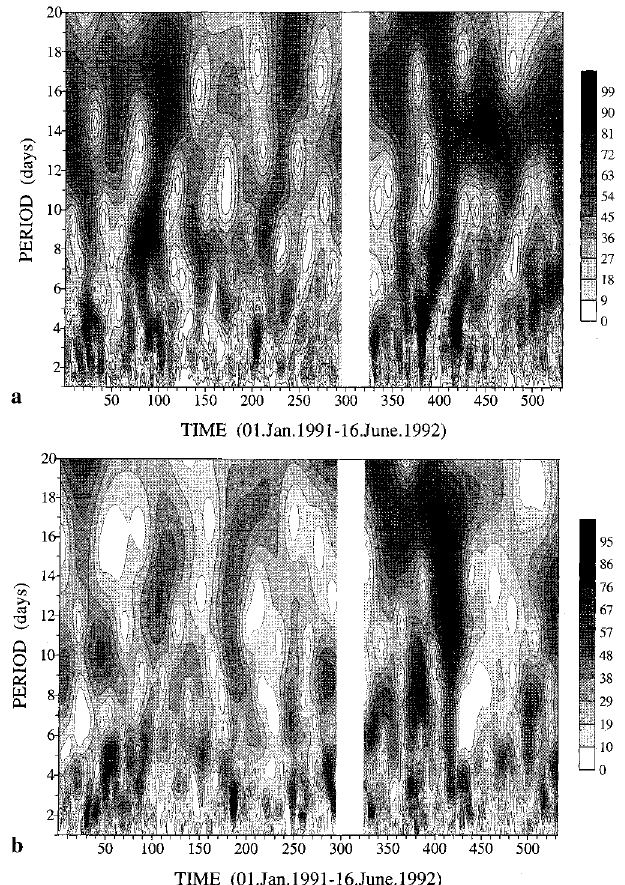
Fig. 10. a The Morlet wavelet transform of the amplitudes of semidiurnal meridional tide for the interval January 1991–June 1992. b The same as a , but for the amplitudes of diurnal